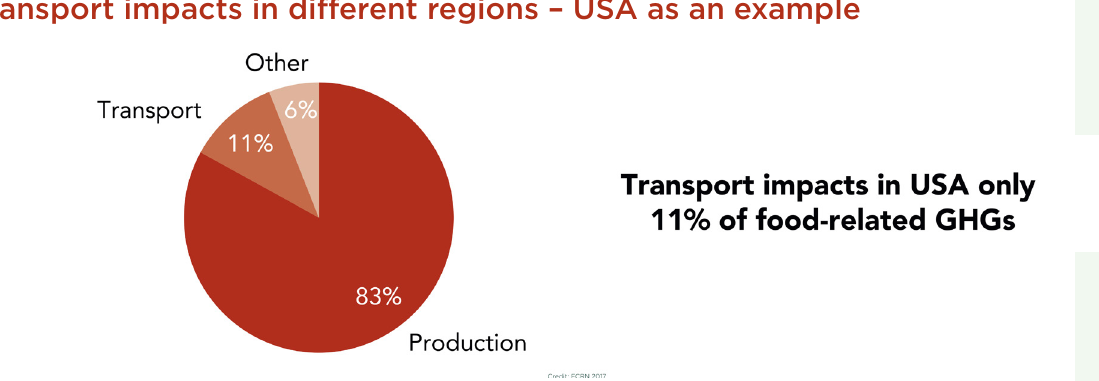
Figure 17: Relative contribution of transport to food related greenhouse gas emissions in the United States of America. Source: Weber and Matthews.